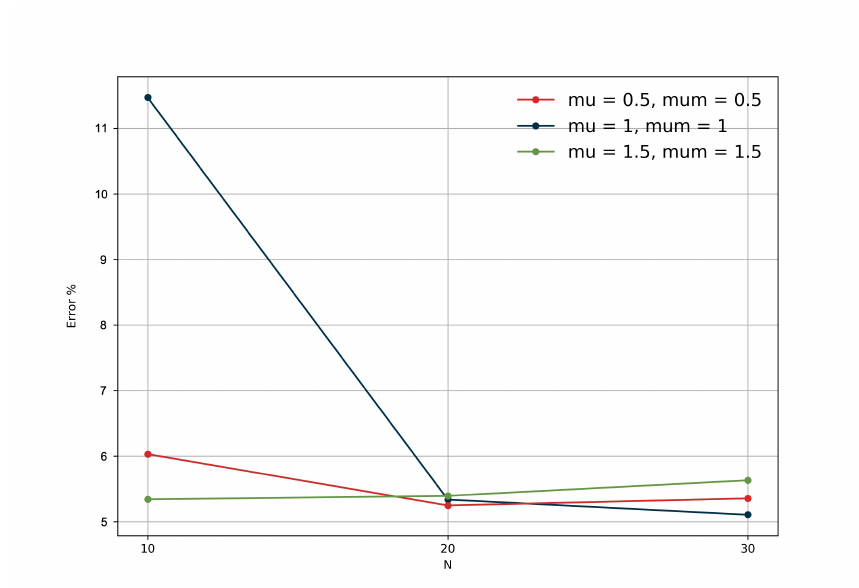
Figure 4. Normalized Root Mean Squared Deviation (NRMSD) % evolution according to population size, crossover and mutation rates.